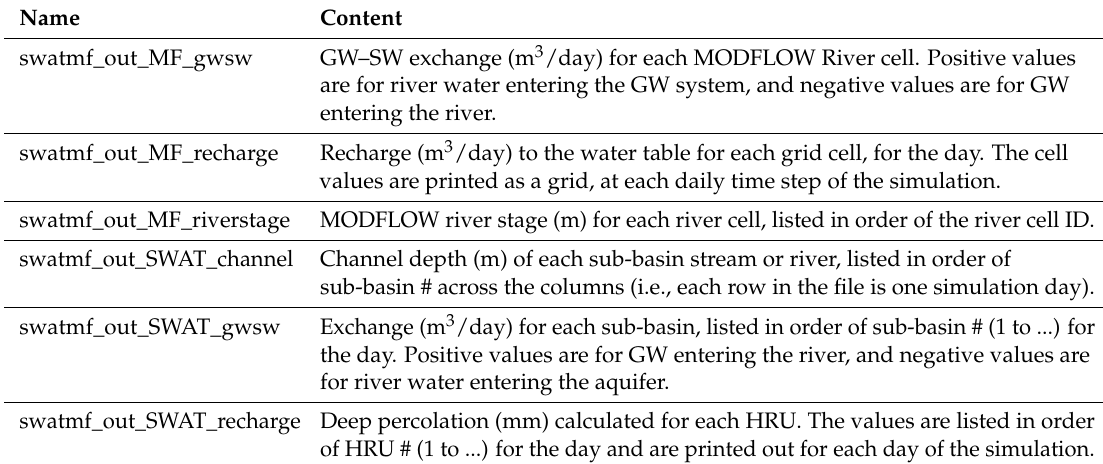
Figure A3. 3-D diagram of the MODFLOW model, with each color representing the hydraulic conductivity found at that point. Many of the model layers have more than one conductivity value. Table A5. List of SWAT–MODFLOW outputs and their contents (modified from Beets [46]).